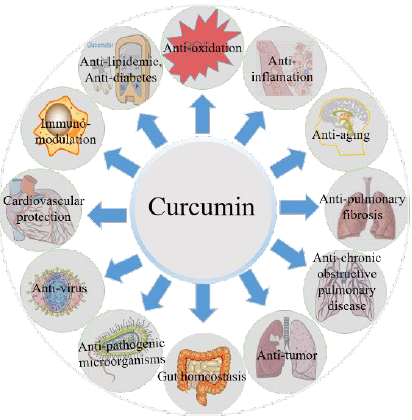
Figure 1. A diagram depicting the biological effects of curcumin.